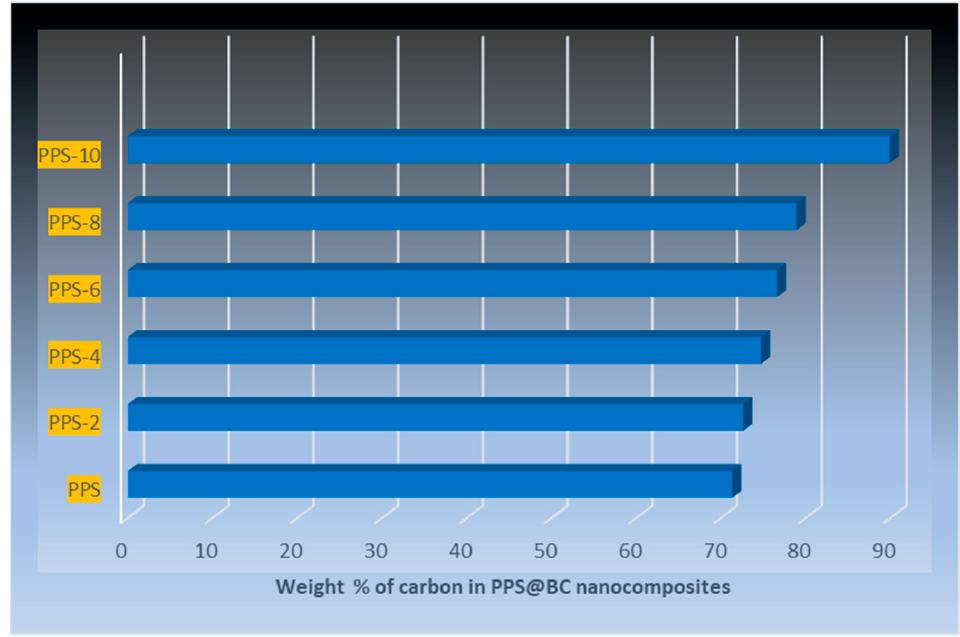
Figure 16. Quantitative analysis results of the weight fraction of carbon using EDS.